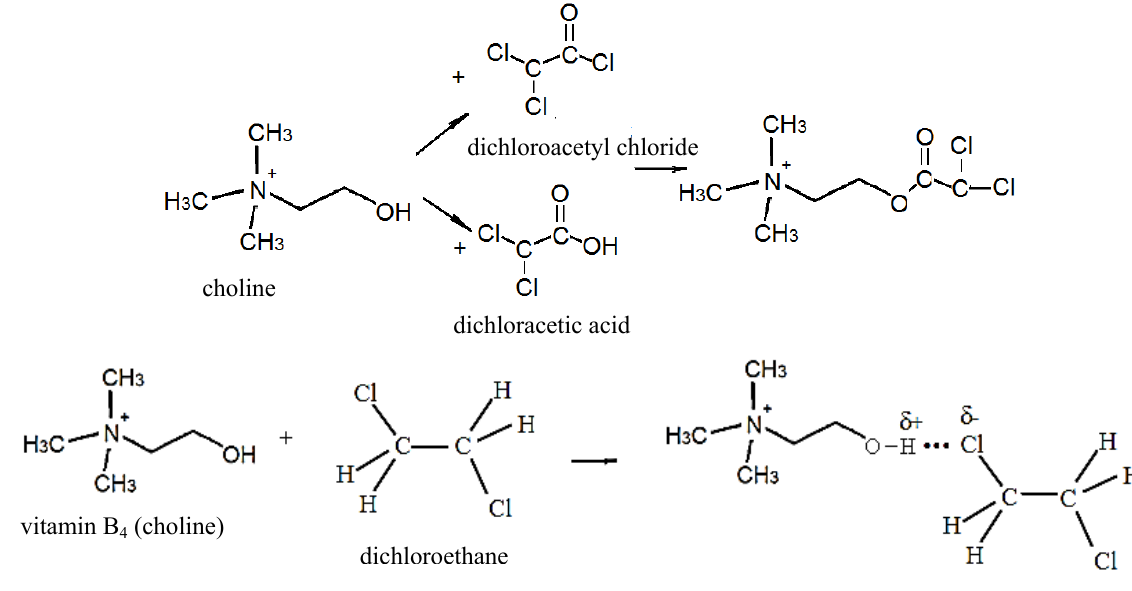
Fig. 16. Chemical interaction of vitamin B 4 with the priority contaminants contained in water.